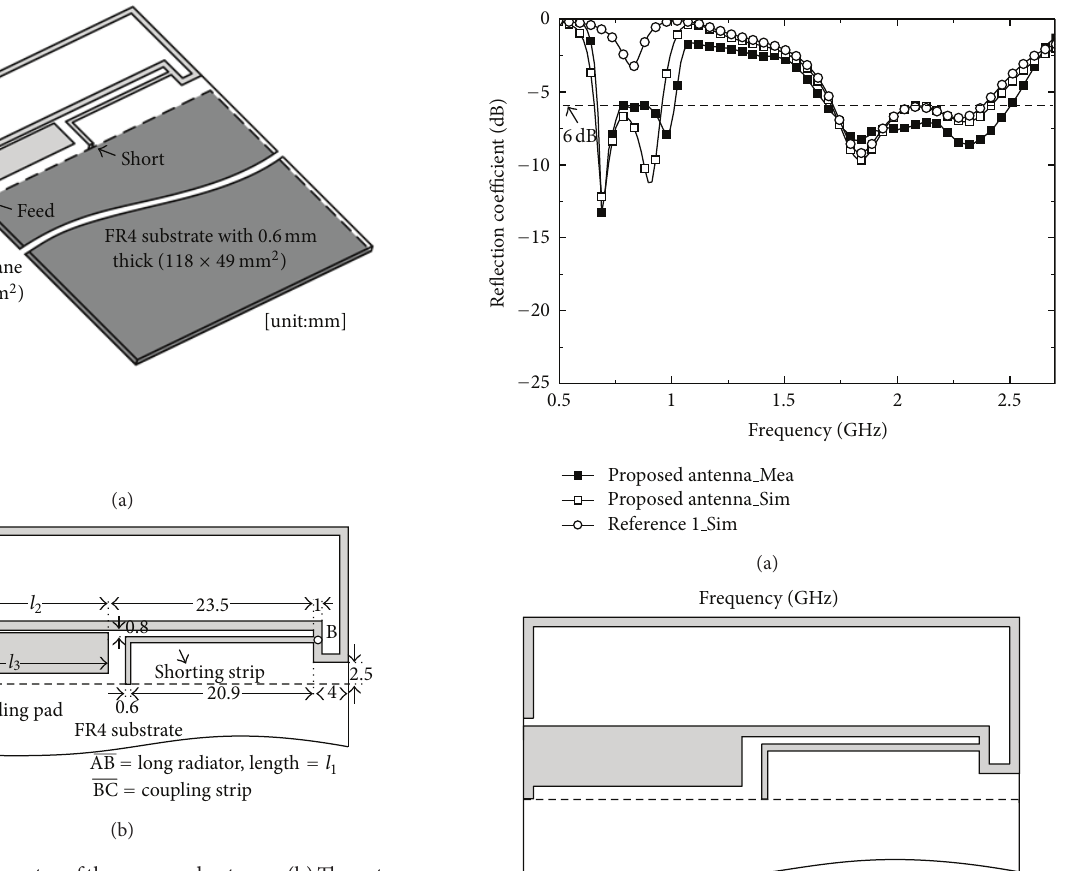
F1:(a)3Dgeometryoftheproposedantenna.(b)eantenna geometry as seen from above.